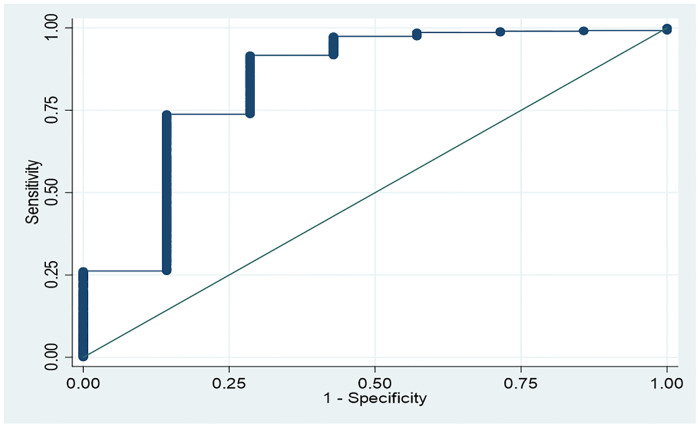
Receiver-operating characteristic (ROC) curve in the whole population by different cutoff values in the change of blood flow velocity after normal saline bolus administration.The area under ROC curve was 0.84.